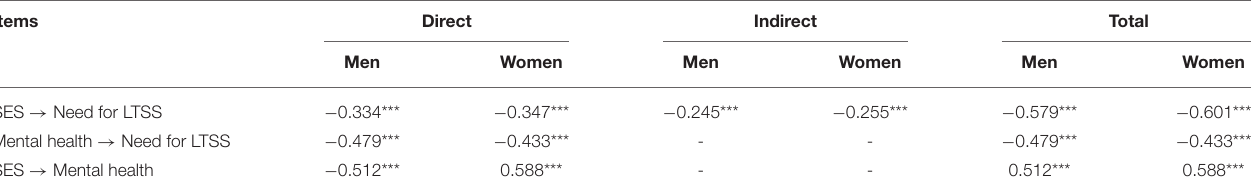
TABLE 4 | Standardized effects between SES, mental health, and need for LTSS by gender. Items